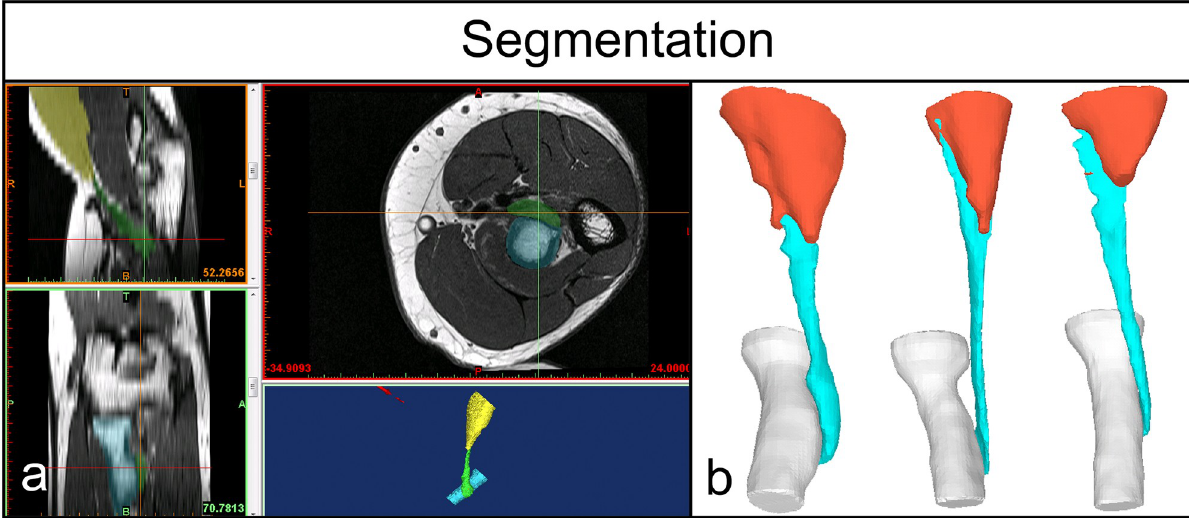
Fig 2. Segmentation. a) Manual segmentation of the distal biceps tendon, proximal radial bone and distal muscle belly of the brachial biceps. b) Generation of 3D surface models: Three